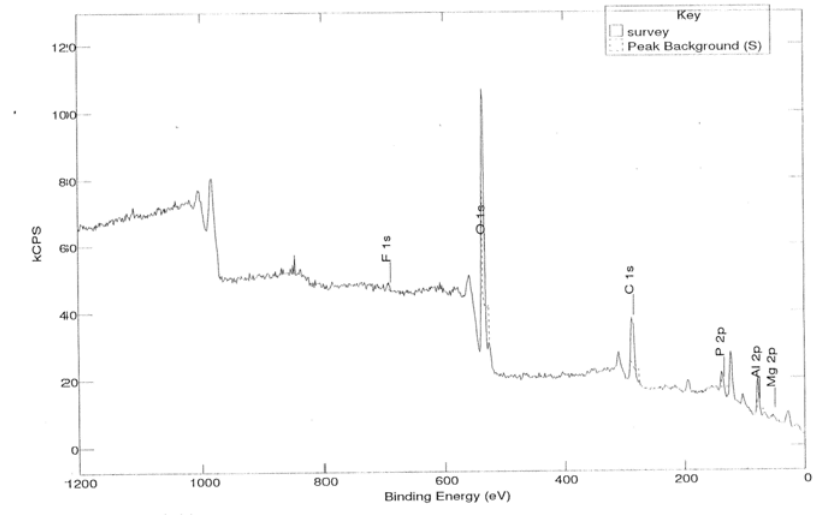
Figure 3 . XPS full scan spectra of AlP technical (85%) by argon ion